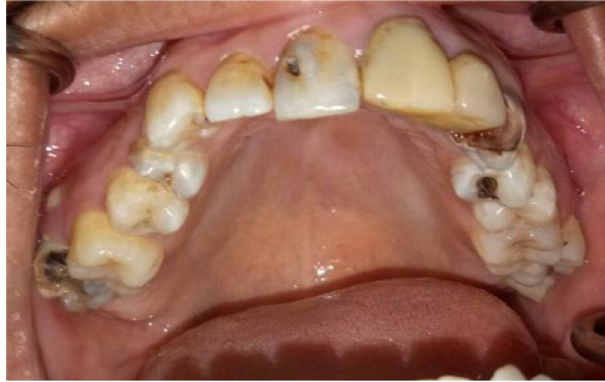
Fig. 4. Intraoral view of the upper